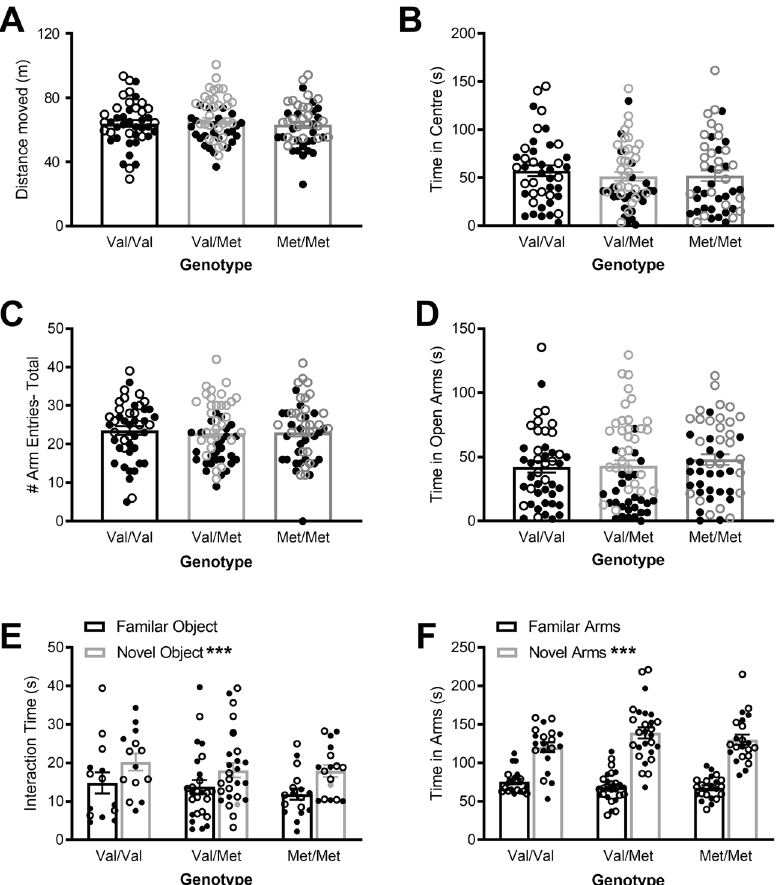
Fig. 3 Anxiety-like behavior and learning and memory in adult rats. Distance traveled ( A ) and time spent in the center of the open fi eld ( B ), as well as total number of arm entries ( C ) and time spent in the open arms of the EPM ( D ) demonstrate no differences in baseline locomotor activity or anxiety-like behavior between genotypes. Time interacting with a novel compared to familiar object in the NORT ( E ) and time spent in novel compared to familiar arms of the Y-maze ( F ) showed that, while rats showed a signi fi cant preference for the novel object or arm, there were no differences between genotypes. Data presented as mean ± SEM with individual data points for all rats. There were no signi fi cant interactions between genotype and sex therefore all data are presented as sexes combined (males closed symbols, females open symbols). *** p <